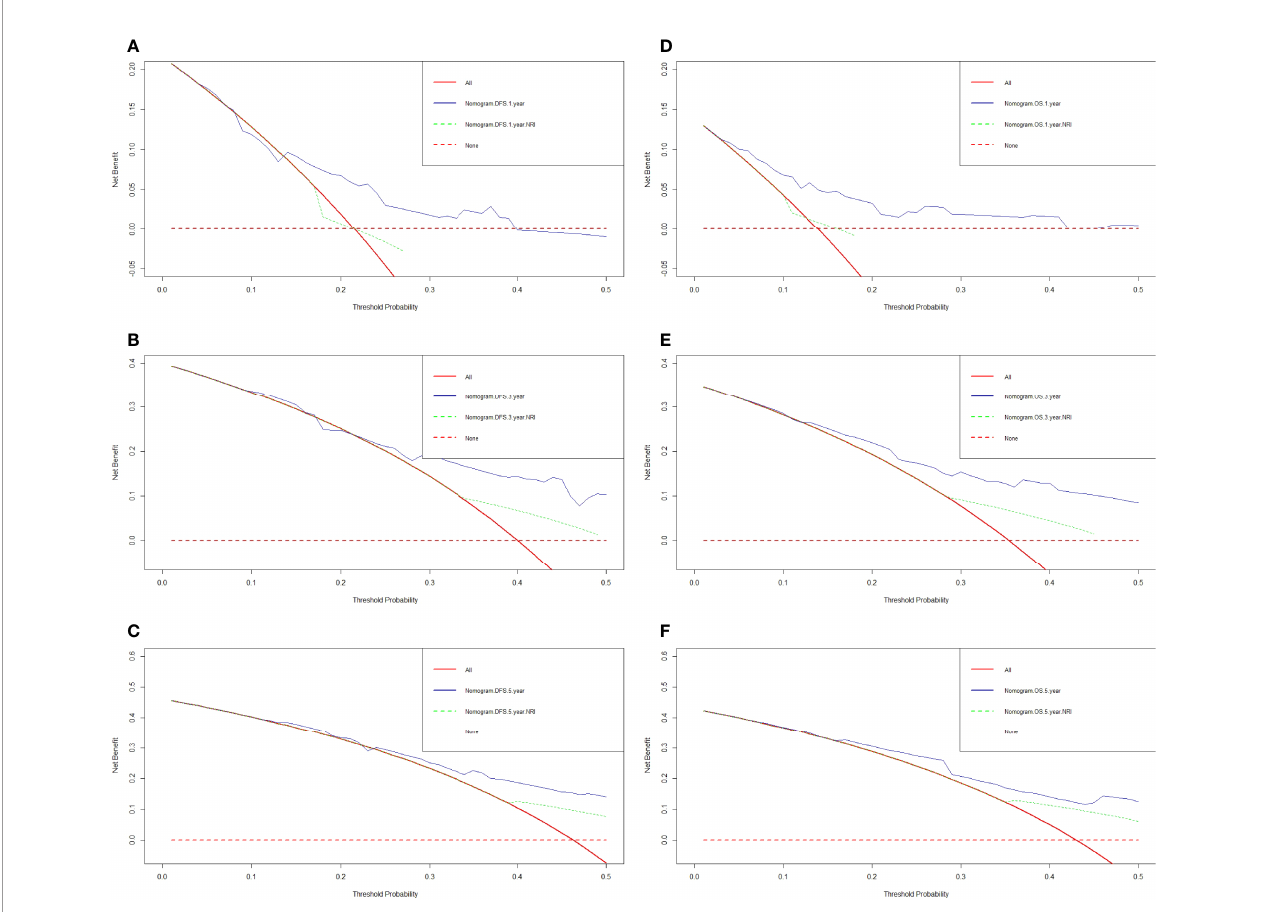
FIGURE 5 | Decision curve analysis for the nomogram and only NRI. (A) 1-year DFS by decision curve analysis; (B) 3-year DFS by decision curve analysis; (C) 5- year DFS by decision curve analysis; (D) 1-year OS by decision curve analysis; (E) 3-year OS by decision curve analysis; (F) 5-year OS by decision curve